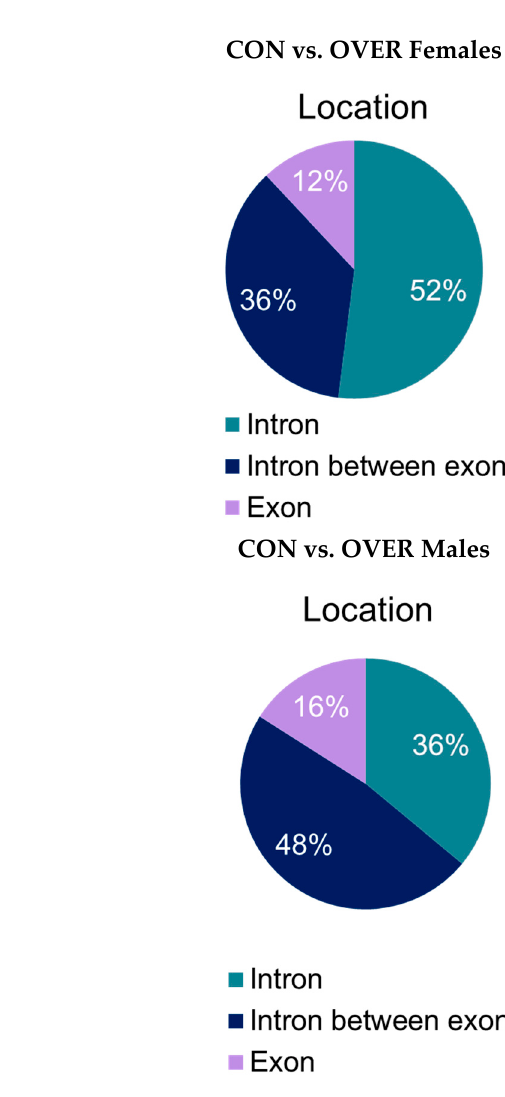
Figure 4. Differentially methylated region (DMR) locations. A total number of 34, 64, 48, and 25 DMRs were identified for CON vs. RES females, CON vs. RES males, CON vs. OVER females, and CON vs. OVER males, respectively. Locations of DMRs were determined using Ensemble. DMRs were considered to be located in a promoter region if they were within 5 kb upstream from the start site of a gene.